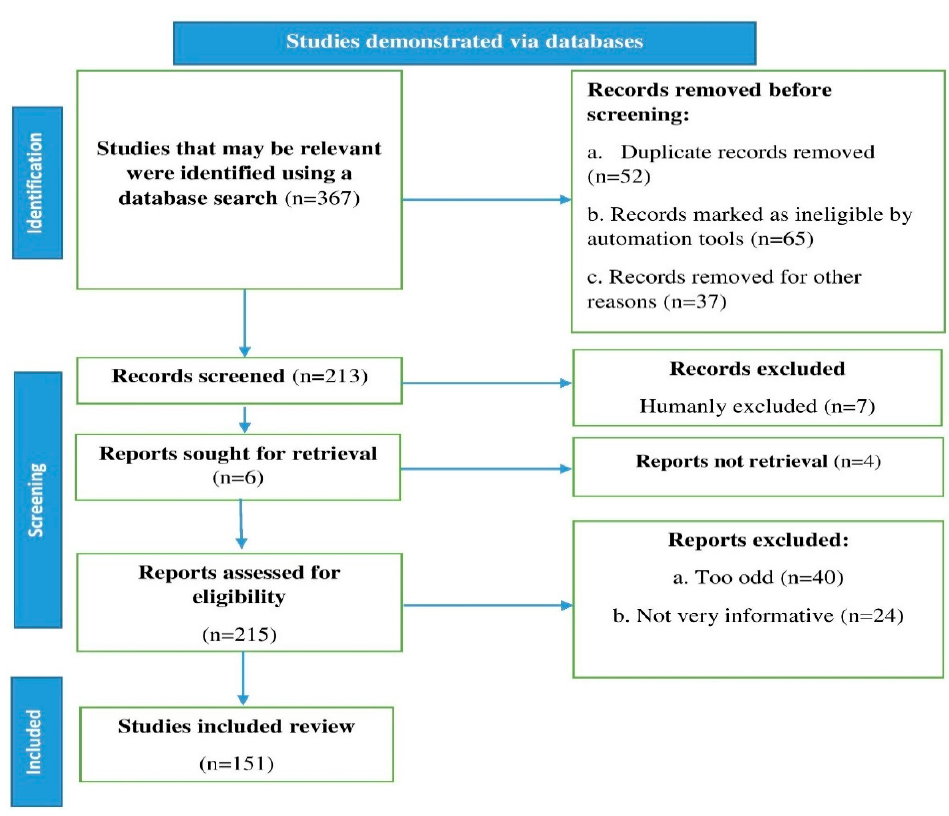
Figure 1. A flow chart illustrating the required steps when choosing published data to be used in the current study; n = number of literature reports.